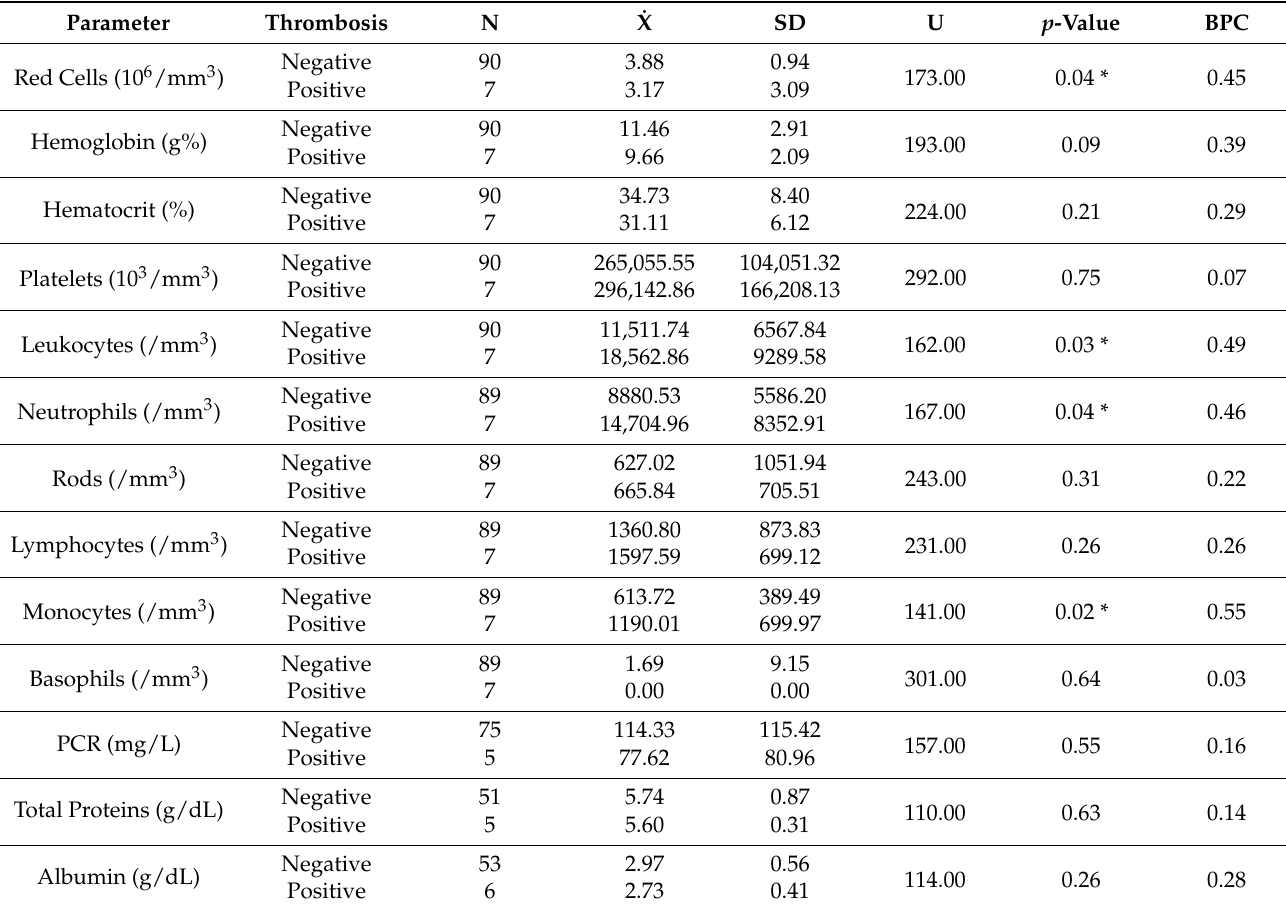
Table 6. Description and comparison of clinical laboratory parameters among patients with clinical suspicion of COVID-19, confirmed or not for a thrombotic event, assessed in a hospital in the Tri â ngulo Mineiro region, Brazil.